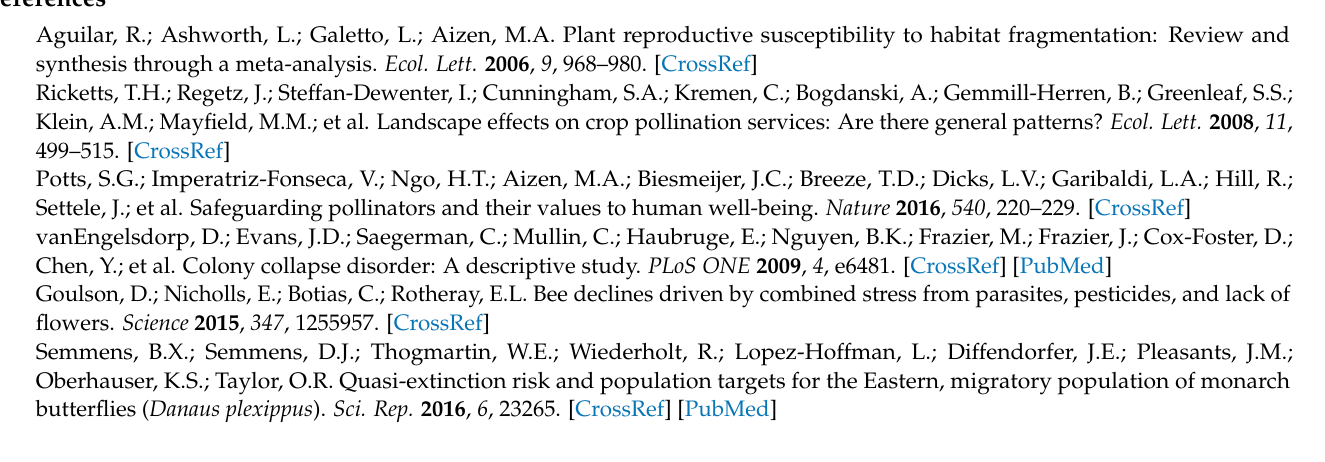
Figure S2: DWV-A load measured in worker honey bees (without antennas) of different ages